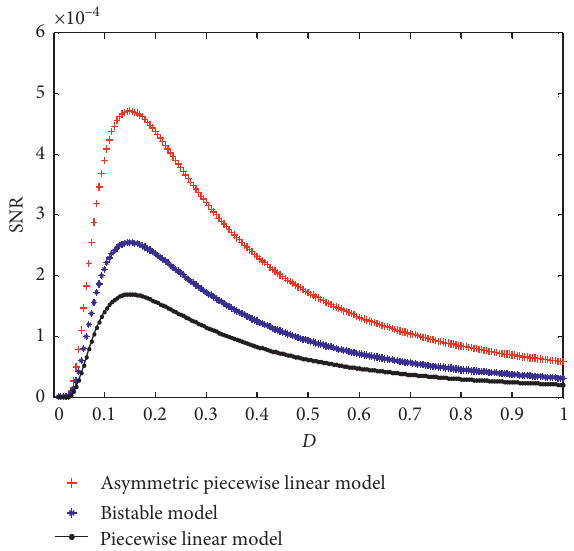
Figure 2: Variation of SNR with D in the three